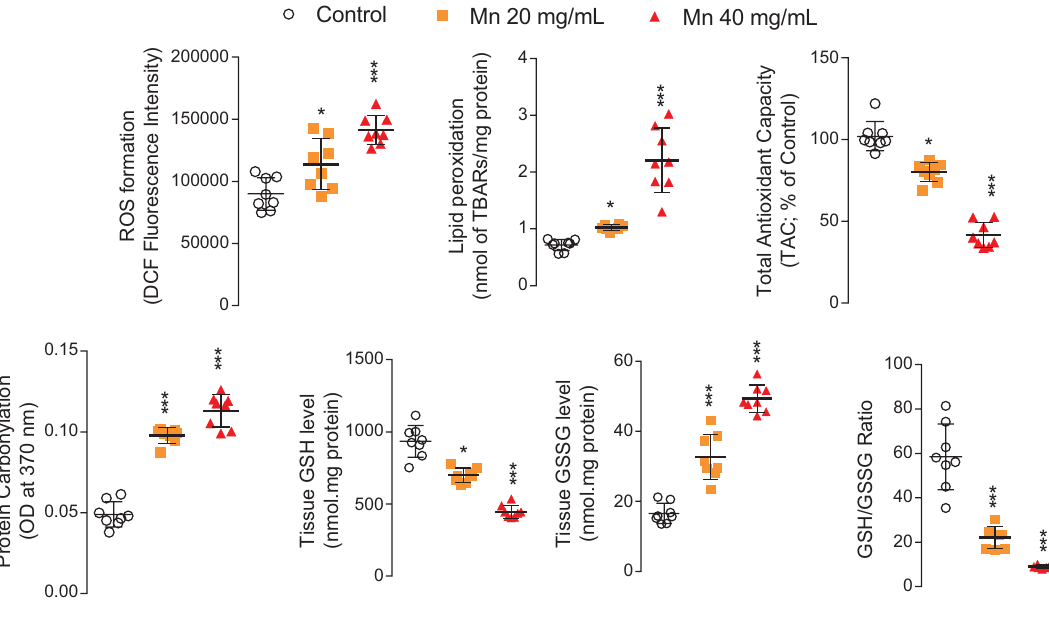
Figure 2 . Markers of oxidative stress in the kidney tissue of manganese-treated rats. Data are given as mean ± SD (n = 8). Asterisks indicate significantly different from the control group (* P < 0.05, *** P < 0.001).